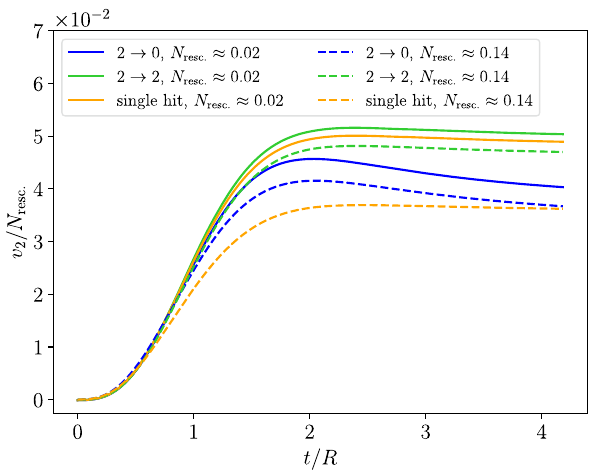
Fig. 4 Ratio v 2 ( t )/ N resc . in systems with initially ε 2 = 0 . 15 and on average N resc . ≈ 0 . 02 (full lines) or 0 . 14 (dashed) rescatterings per particle for the three scenarios of the transport cascade: 2 → 2 (green), 2 → 0 (blue), single hit